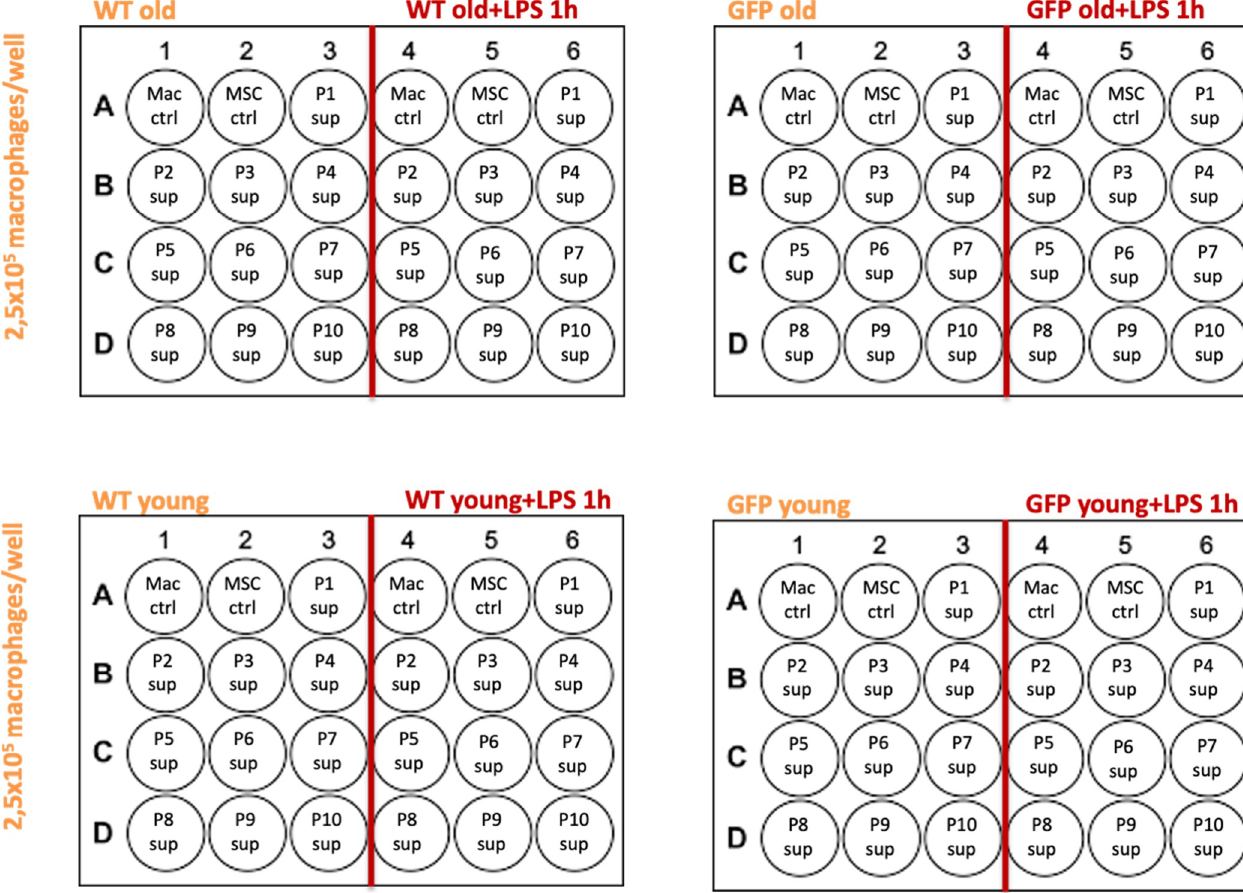
Figure A3. Confirmation of MSC differentiation into osteocytes and adipocytes. 10x magnification of MSCs after stimula- tion with osteogenic and adipogenic differentiation media. Alizarin-red-staining for cells after osteogenic differentiation is shown in ( a ). Oil-red-O staining for adipocytes after differentiation is shown in ( b ).